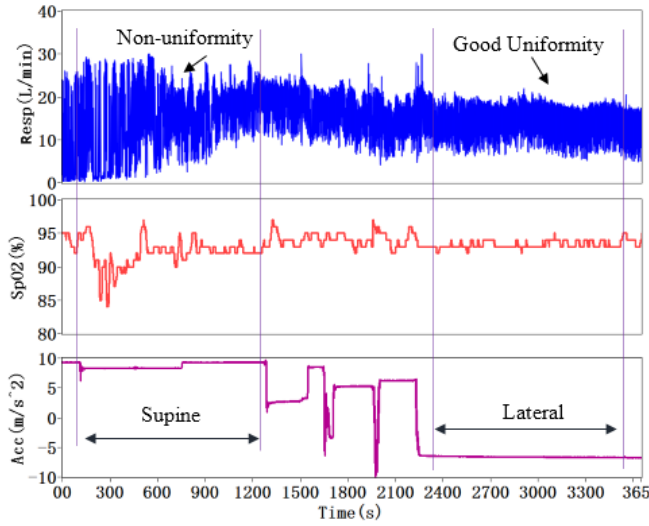
Figure 15. Monitoring of sleep posture, SpO 2 , and respiration.